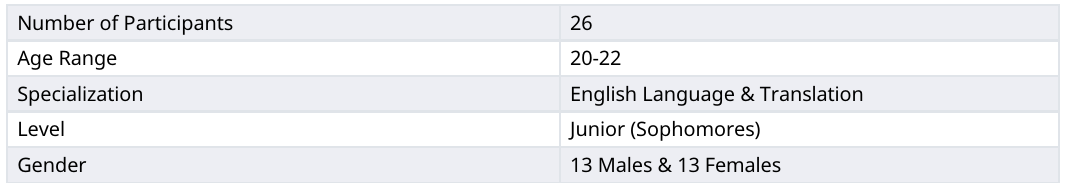
Table 1. Learners' demographic